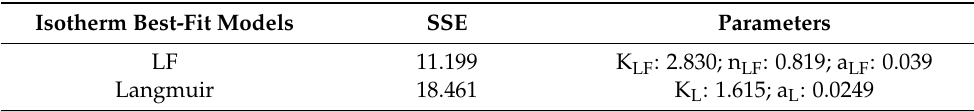
Table 5. Best-fit isotherm